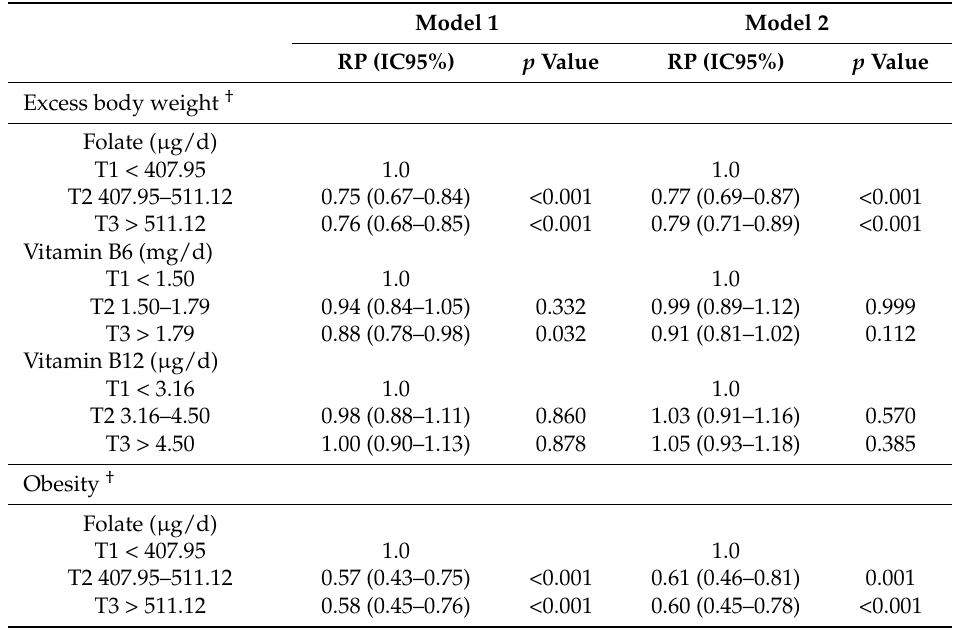
Table 3. Prevalence ratio (PR) for excess body weight * and obesity ** according to dietary folate, vitamin B6, and vitamin B12 of the CUME participants ( n =